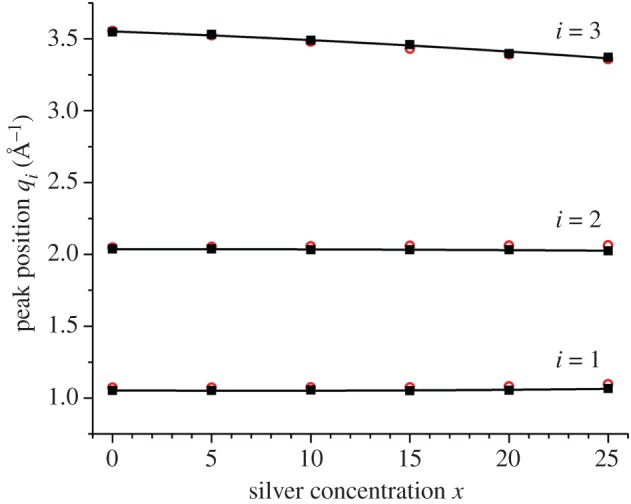
The composition dependence of the first three peak positions qi (i=1, 2 or 3) in SN(q) (filled squares) or SX(q) (open (red) circles) for glassy samples of NatAgx(Ge0.25Se0.75)(100−x). The curves are drawn as guides for the eye.